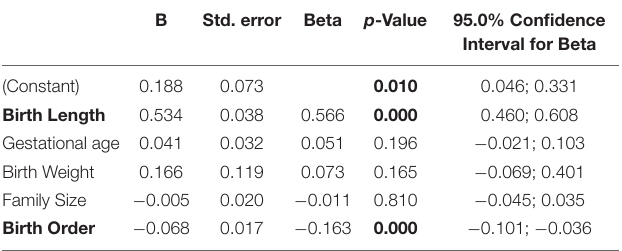
TABLE 3 | Multivariate regression analysis of infancy length SDS.